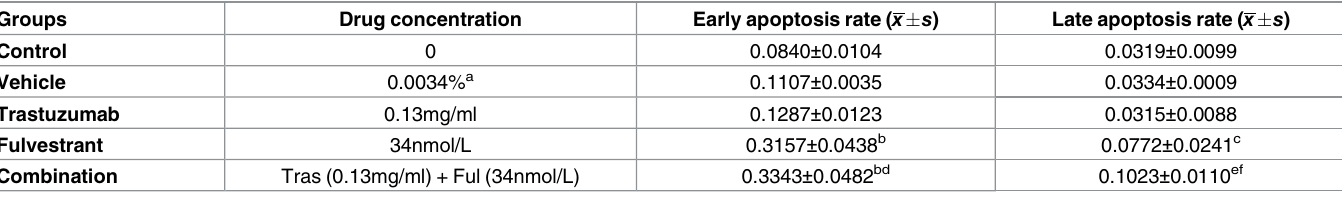
Table 2. Effects on BT-474 cell apoptosis treated with trastuzumab and fulvestrant as single agents or with a combination of both. Groups